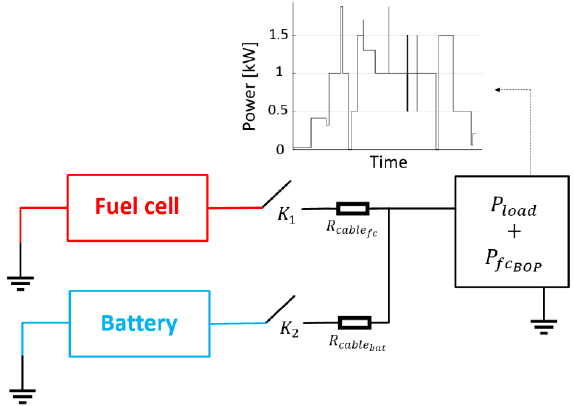
Figure 2. Simplified diagram of the direct hybrid system.